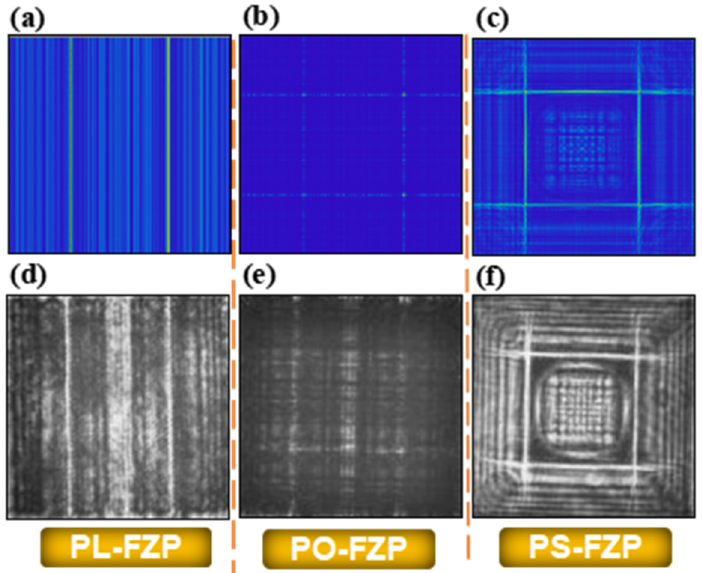
Figure 10. Diffraction pattern of phase-shifted quadrate FZPs: ( a – c ) Simulated diffraction pattern; ( d – f ) experimental diffraction pattern.